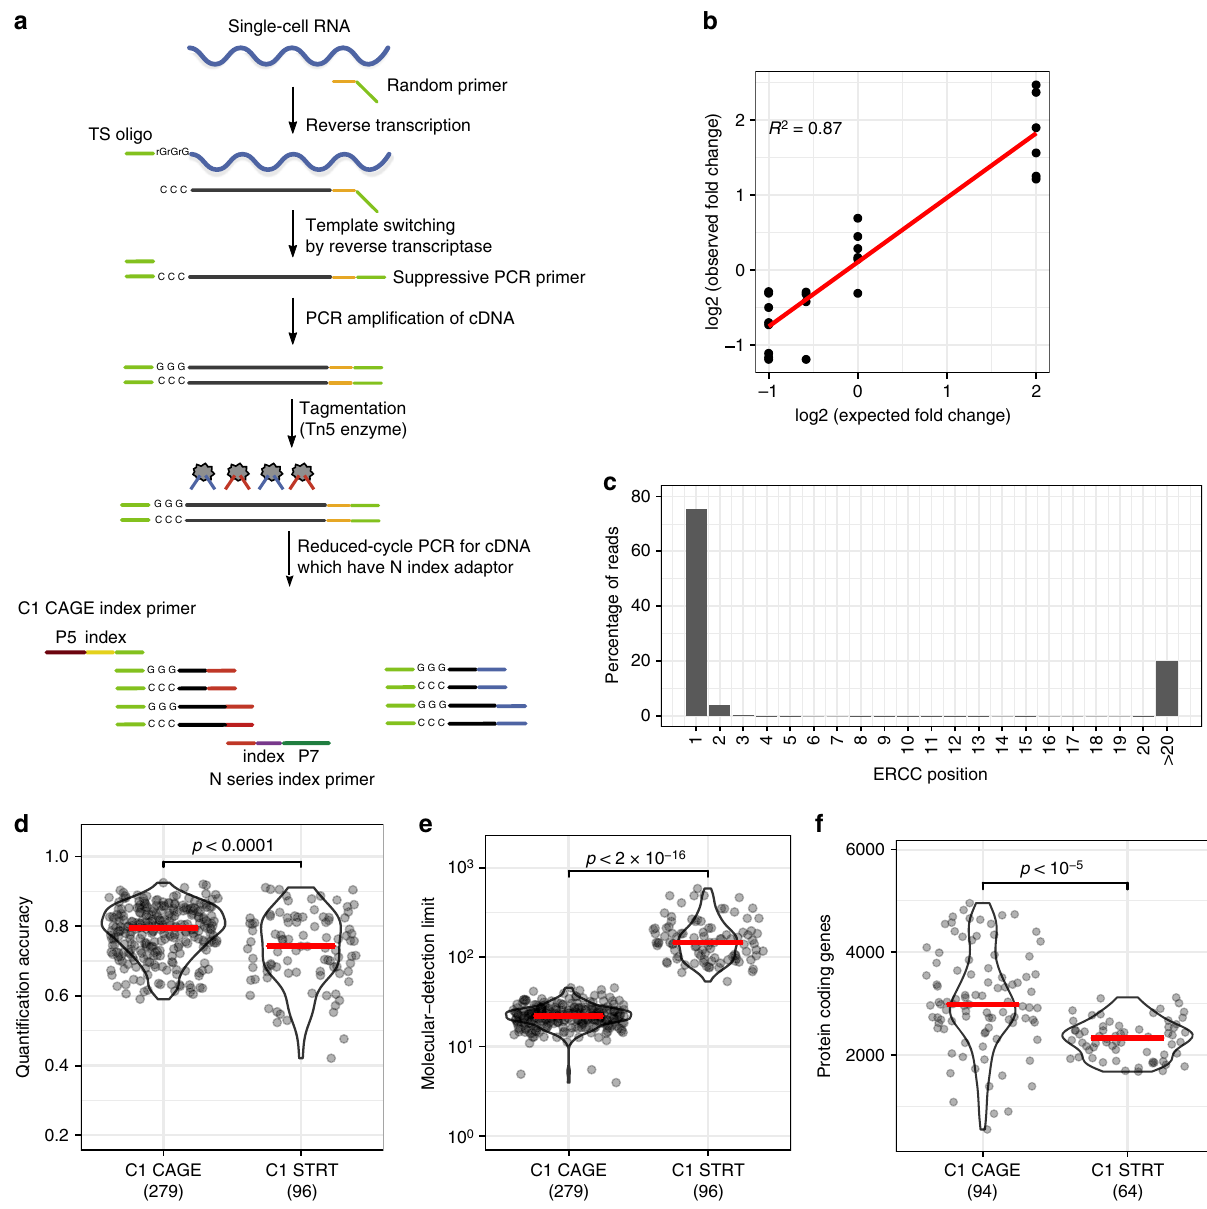
Fig. 1 The C1 CAGE method and performance. a Schematic of the C1 CAGE method. Tn5 enzymes are loaded with two different adapters: N (red) and S (blue). P5, P7: Illumina sequencing adapters. b Observed and expected fold-change ratios between ERCC mix1 and mix2. Linear regression line (red) and R - squared value shown. c Percentage of reads aligning to the 5 ʹ -end of ERCC spike-ins by nucleotide position. d – f Comparison between C1 CAGE and C1 STRT Seq (data from Svensson et al. 24 ) Red bars show median values. p -values from Welch's two-sided two sample t test shown. d Pearson correlation between expected and observed ERCC spike-in molecules. e The number of ERCC spike-in molecules required for a 50% chance of detection. f Protein- coding genes detected in mouse ES cells counting reads within FANTOM5 promoter regions. Source data are provided as a Source Data fi